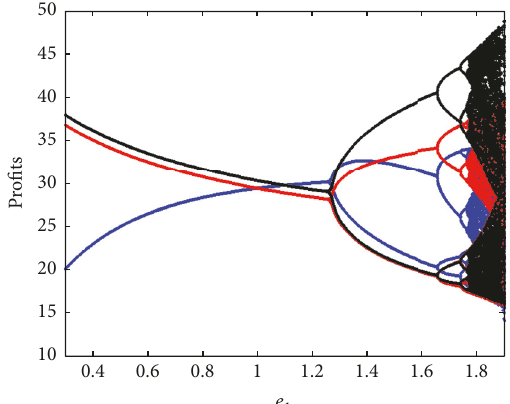
Figure 17: Effects of 𝑒 1 on profits, 𝛼 = 0.2 , 𝛽 = 0.2 , and 𝛾 = 0.1 .